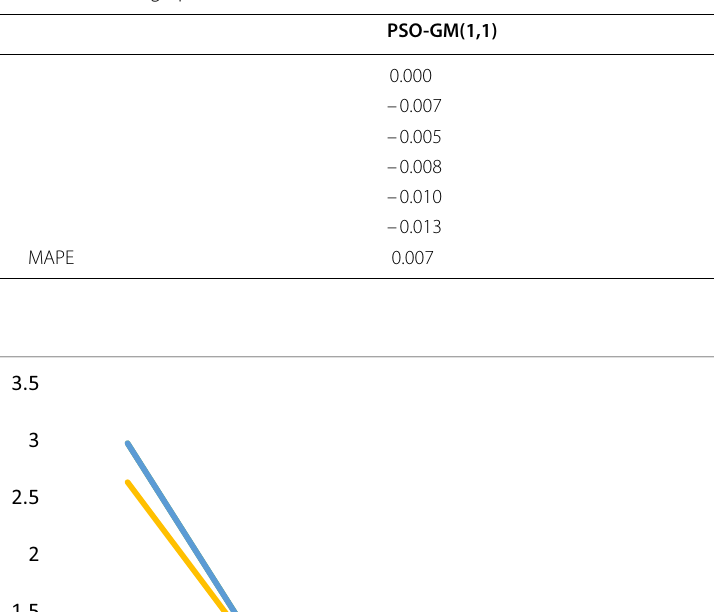
Table 1 Percentage prediction errors for PSO-GM(1,1) and GM(1,1) for a monotonic increasing data